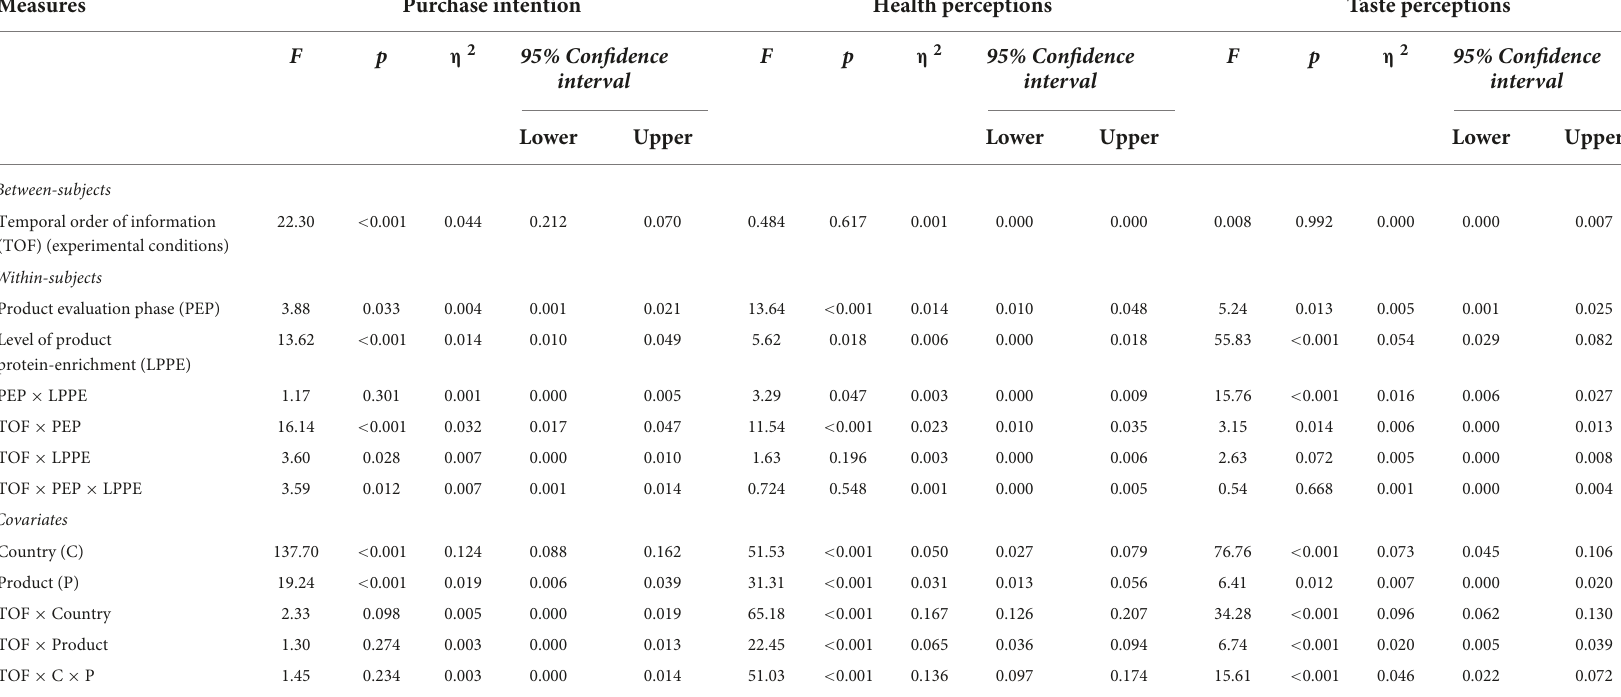
TABLE 2 Effect of temporal order of information (experimental conditions), product evaluation phase and level of product protein-enrichment on participants’ purchase intentions, health perceptions, and taste